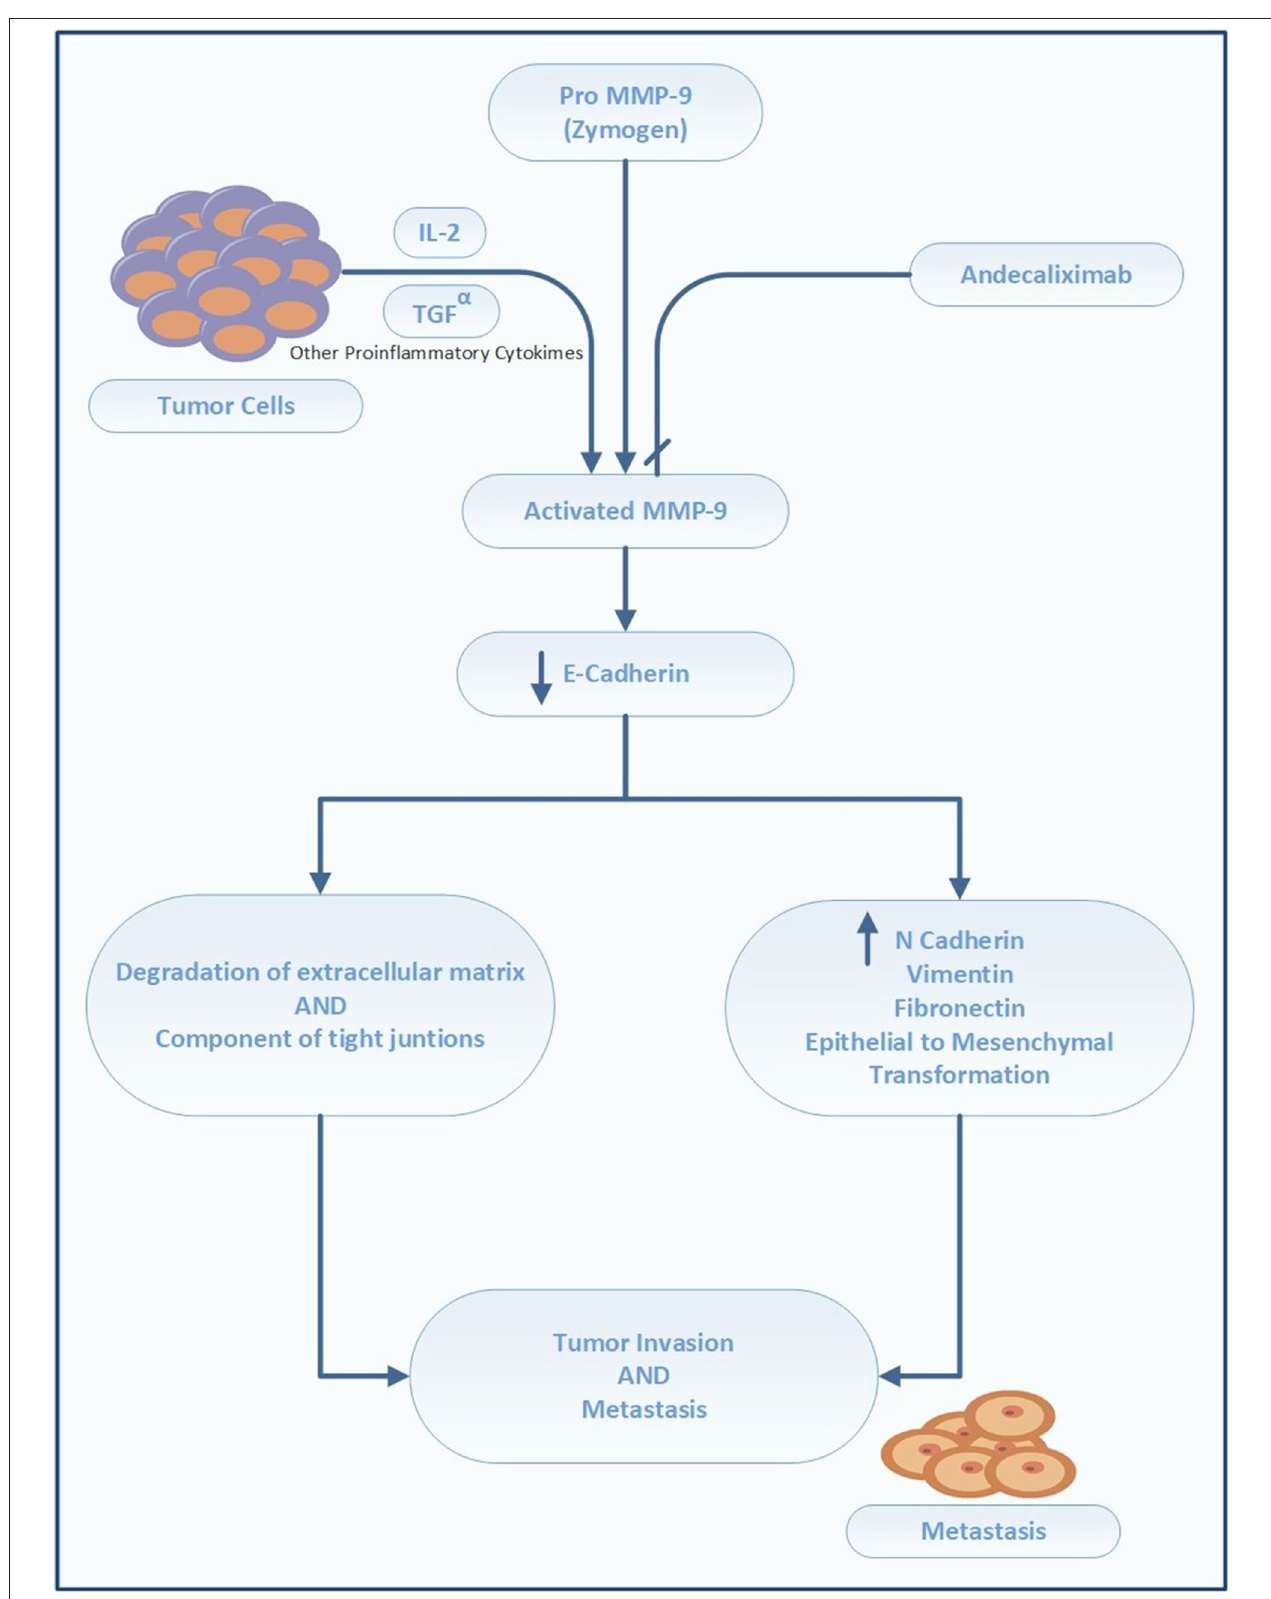
FIGURE 4 | Mechanism and site of action of